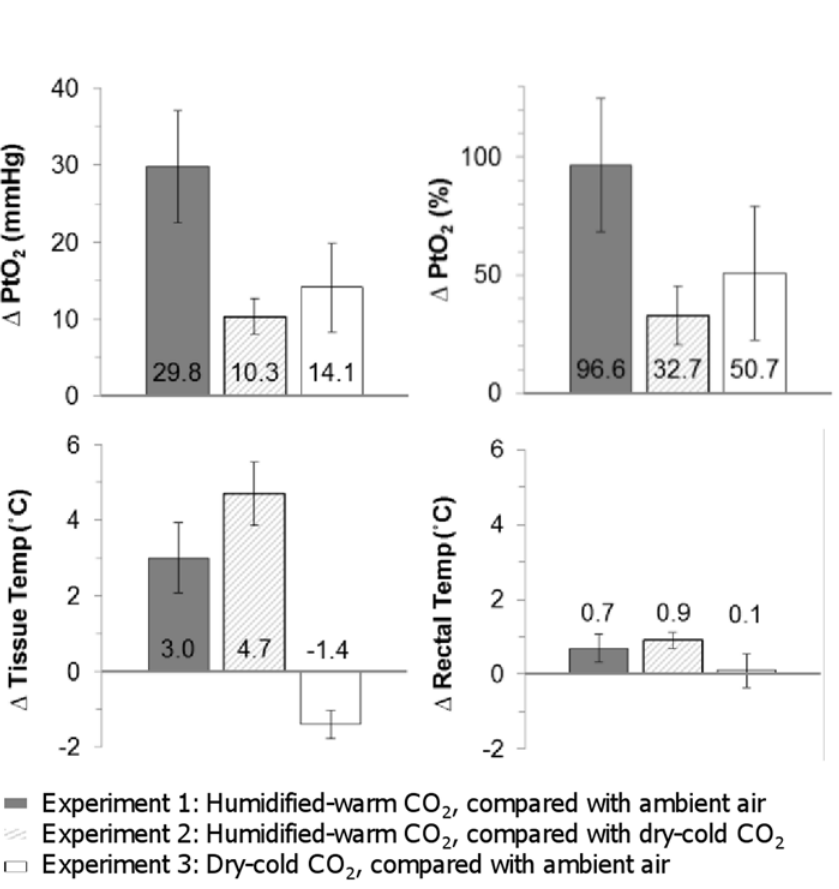
Fig 2. Change in PtO 2 (shown as both an absolute change (mmHg) and relative change (%)), tissue temperature and rectal temperature affected by the intervention condition of each experiment. Error bars show 95% confidence intervals. Where error bars do not cross zero, the intervention had a statistically significant effect compared with the control condition.